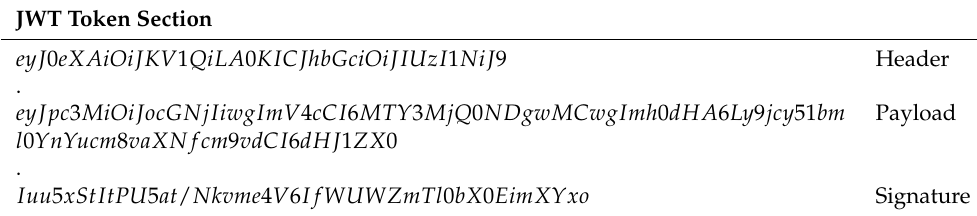
Table 2. Sample base64 encoded JWT